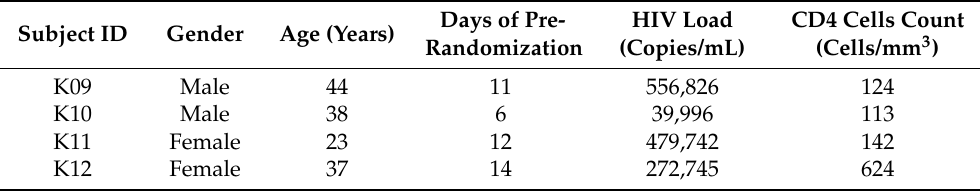
Table 2. Tumor biopsy nucleic acid yield and RNA quality.